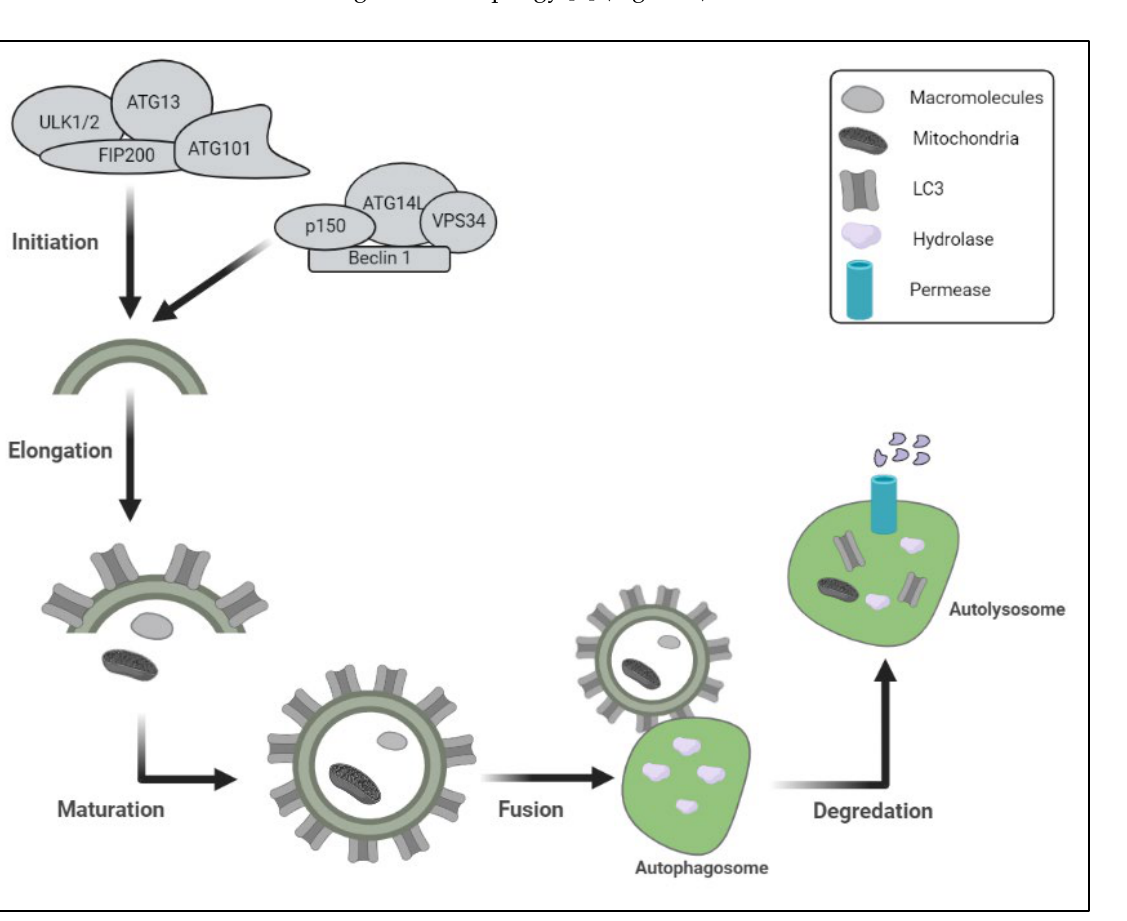
Figure 1. Schematic representation of the protein degradation lysosomal pathway includes different steps of autophagy and proteins involved in initiation of autophagy. (ULK1/2: unc-51-like kinase 1; FIP200: focal adhesion kinase family-Interacting Protein of 200 kDa); ATG13: autophagy-related protein 13; p150: PI3-kinase 150; VPS34: vacuolar sorting protein-34).